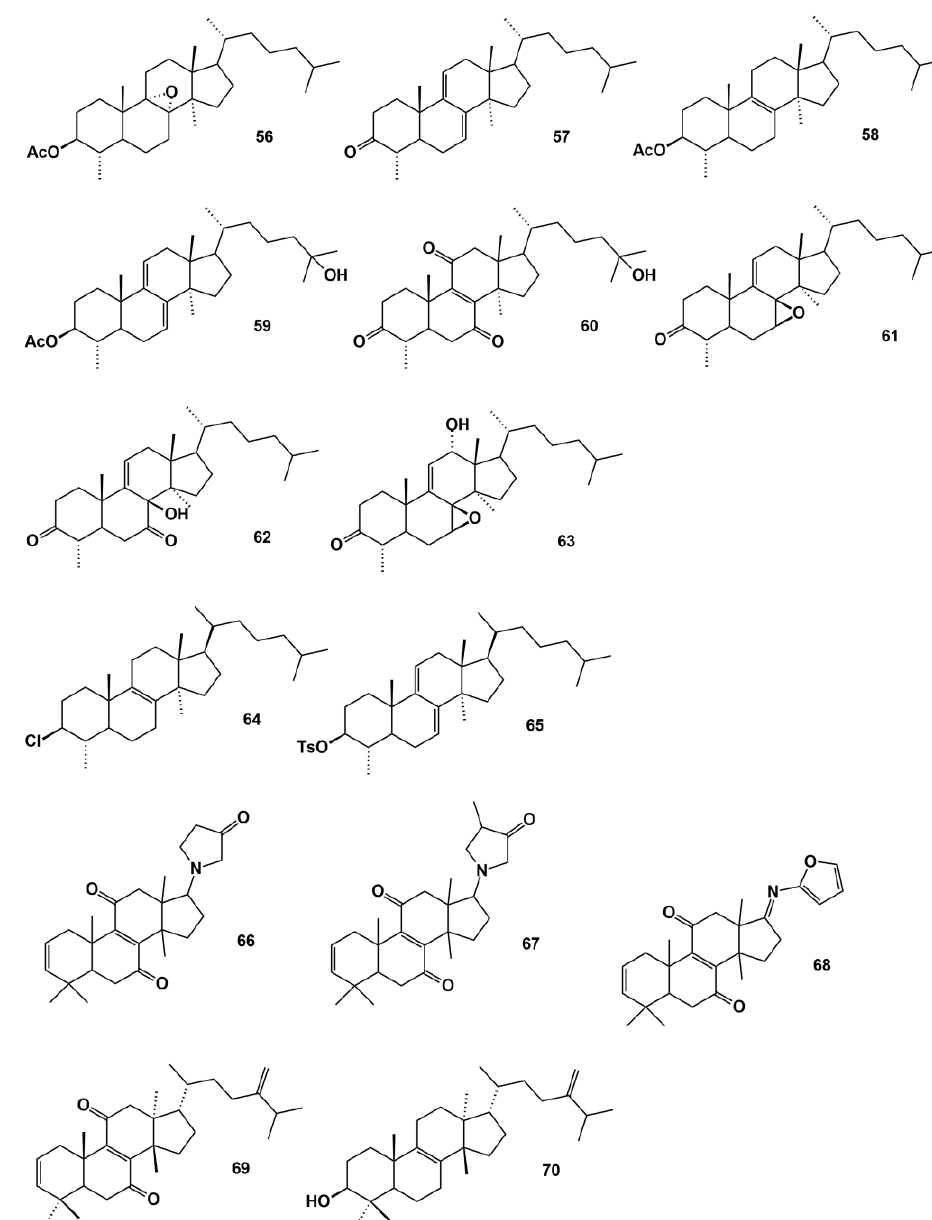
Figure 10. Triterpene derivatives obtained from natural triterpenes isolated from E. officinarum latex. Compounds 66 , 67 and 68 according to the structures presented in Figure 9 of Daoui et al. [48].